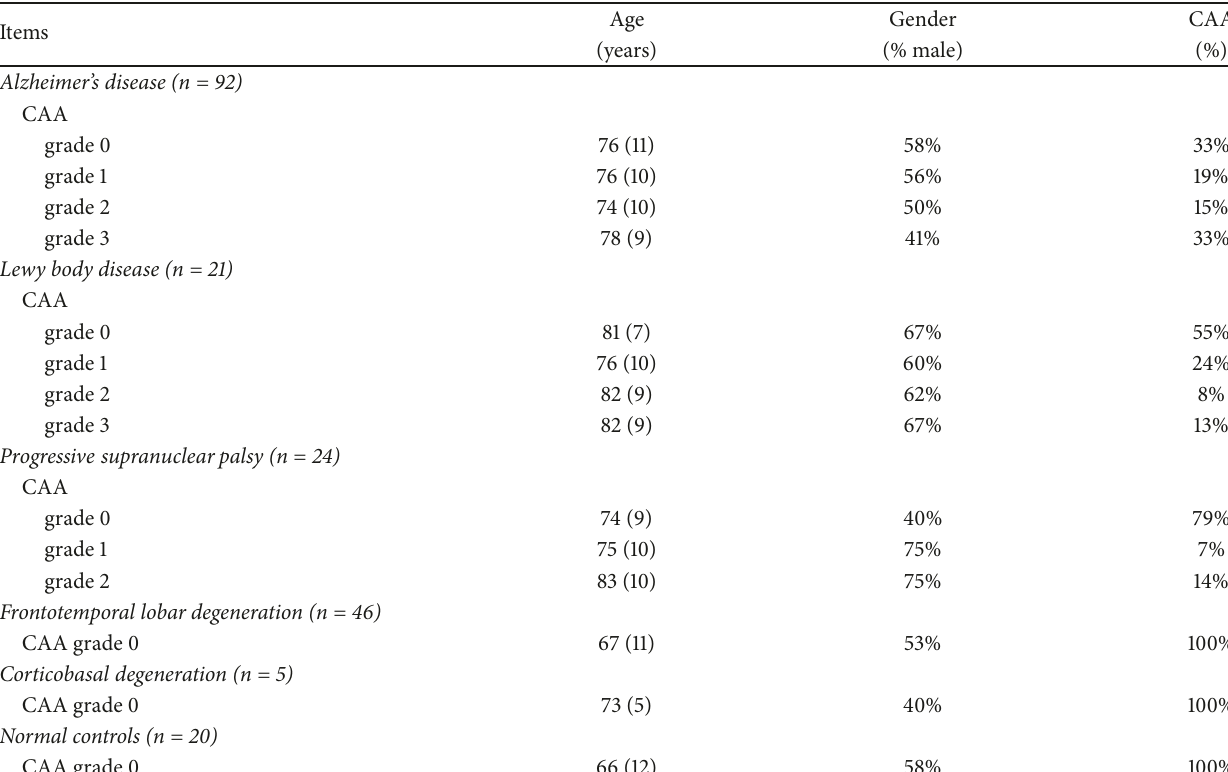
Table 1: Average age (standard deviation), gender distribution and % frequency of cerebral amyloid angiopathy (CAA) according to the grading of its severity in different neurodegenerative dementia diseases.